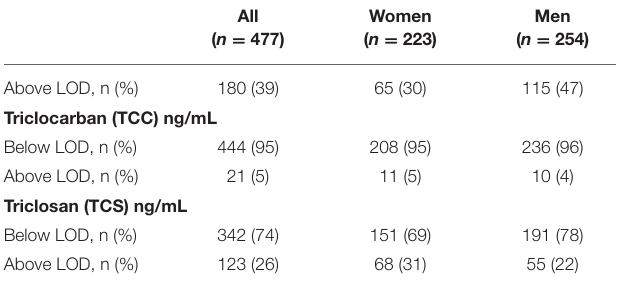
TABLE 1 | Characteristics of study population (total, n = 477) and separately for women and